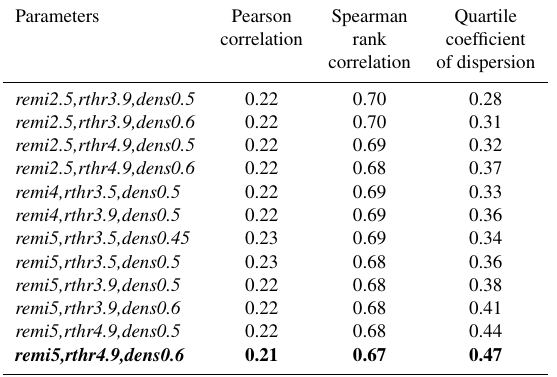
Table 1. Exemplary results of test simulations with different param- eters (emission number geometric mean radius remi in µm, thresh- old radius rthr in µm, and density dens in gcm − 3 ). The scaling factor is the same for all simulations (SF = 34); the numbers hardly depend on the scaling factor. The parameters chosen for further sim- ulations are marked in bold. Parameters Pearson Spearman Quartile correlation rank coefficient correlation of dispersion remi2.5,rthr3.9,dens0.5